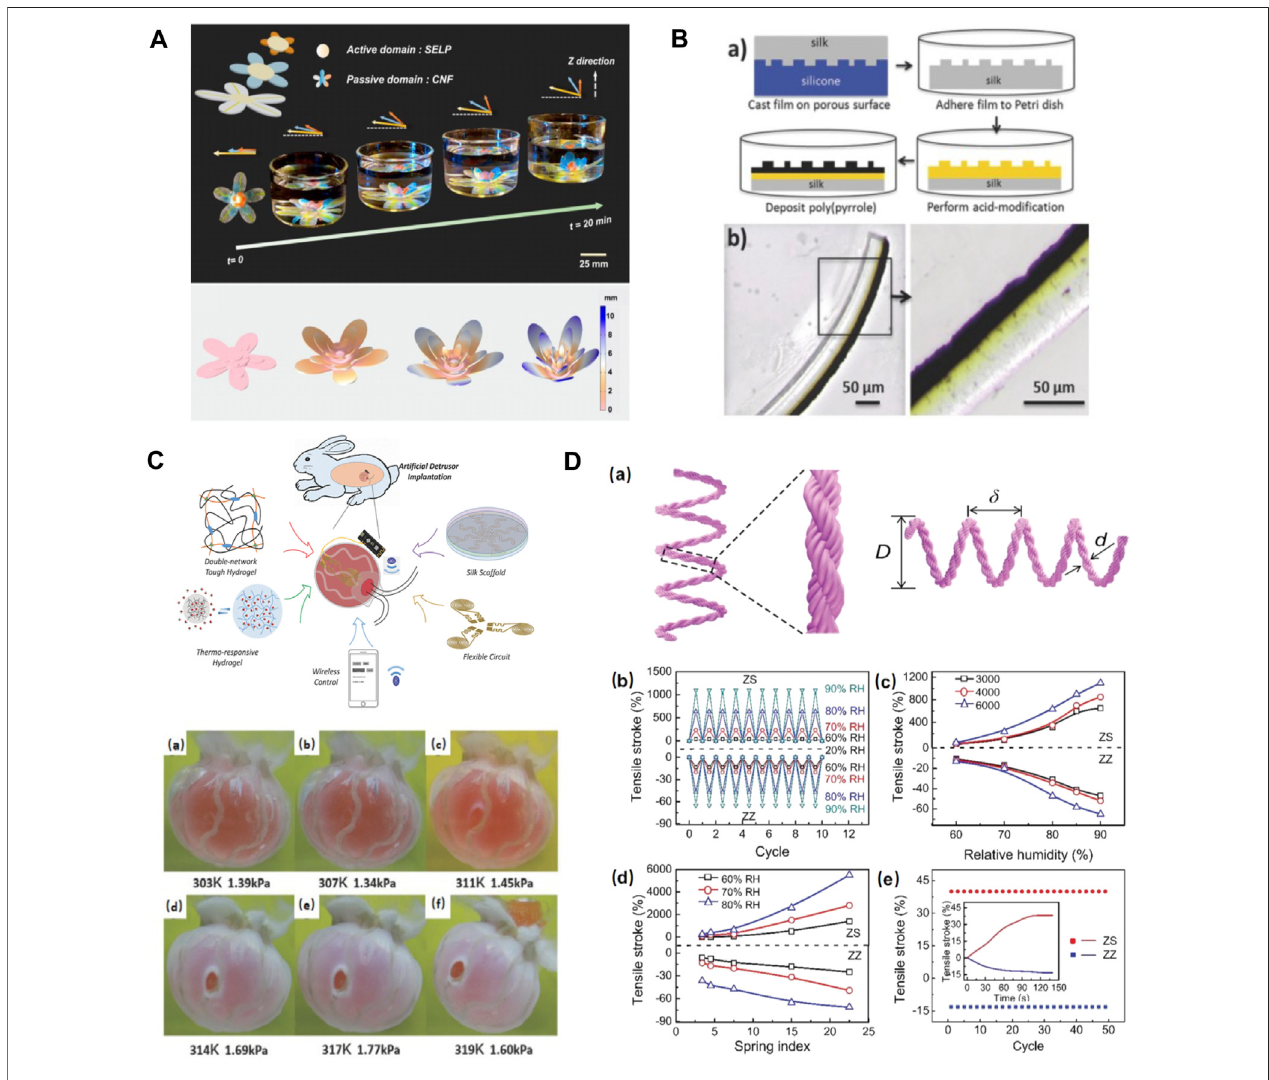
FIGURE 8 | Silk-based biomaterials in soft robotics. (A) SELP/CNF arti fi cial fl ower can alter the petal orientation. The biomimetic SELP-based multilayer arti fi cial fl ower experienced a shape folding in 1 M NaCl solutions due to the response of SELP to the ionic stimulus, which is similar to the petal movements of a natural fl ower. Adapted with permission from ref (Wang Y. et al., 2020). Copyright 2018 Proceedings of the National Academy of Sciences. (B) The formation of an acid-modi fi ed silk- polypyrrolebilayeractuator(yellowpart:acidmodi fi cation,blackpart:polypyrrole).Adaptedwithpermissionfromref(Romeroetal.,2014).Copyright2014WILEY- VCH. (C) Synoptic diagrams for the structure and operating principle of the arti fi cial detrusor. Adapted with permission from ref (Yang et al., 2018). Copyright 2018 WILEY-VCH. (D) Fabrication and performance of tensile silk muscles. Adapted with permission from ref (Jia et al., 2019). Copyright 2019 WILEY-VCH.